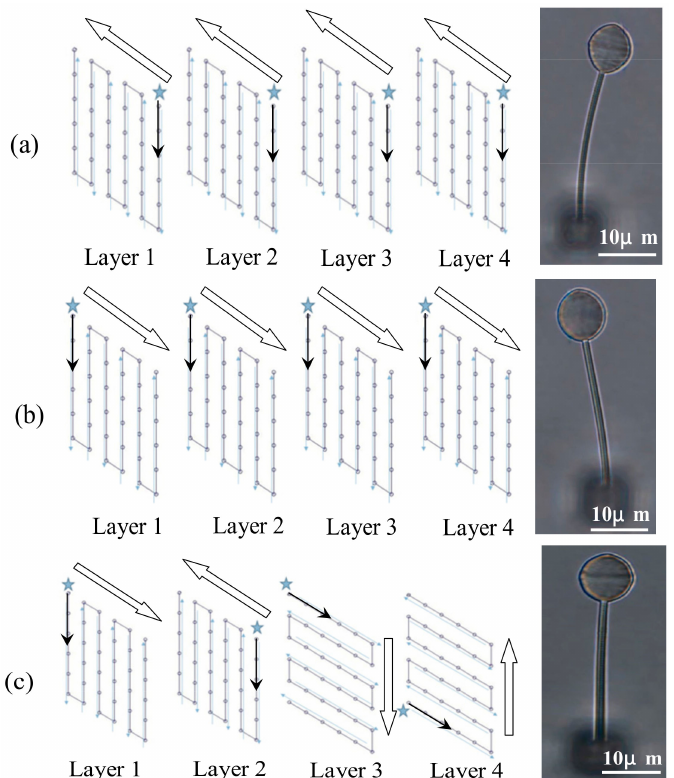
Figure 6. Different rastering directions (stars indicate the starting point of a path) and the top view of the resulting specimens: When the trajectories start at the same corner and follow the same direction in each plane, ( a , b ) the resulting bar will curve to the side of the trajectory starting point and the sphere is elongated; when the rastering directions in adjacent planes are alternated, ( c ) a straight bar with a relatively undistorted sphere